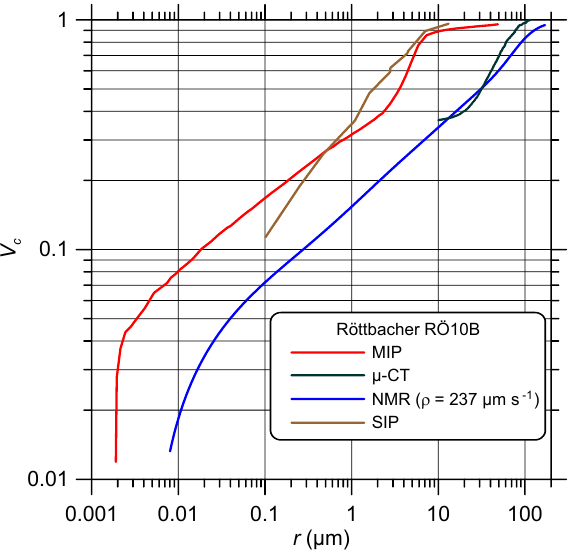
Figure 8. The comparison of V c − r curves determined from MIP, µ -CT, NMR, and SIP for Röttbacher sandstone sample